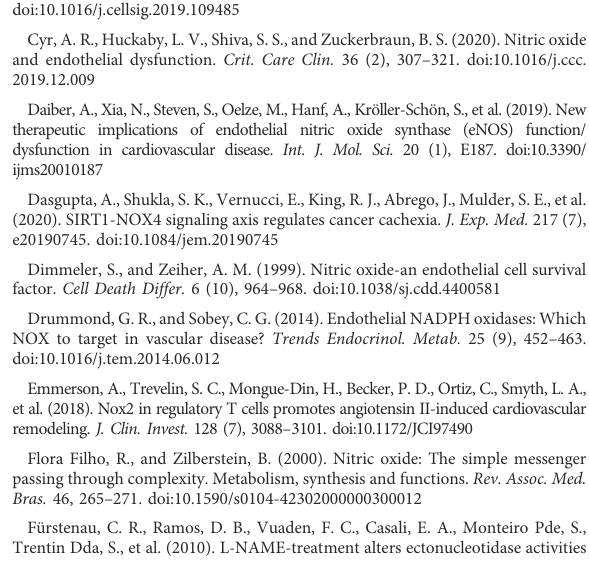
Cell viability of the thymus-derived endothelial cell line tEnd.1 after treatment with L-arginine (100 µM) and L-NAME (1, 10, 100 µM, 1 mM) for 12, 24, 48, 72, 96 and 120 h without retreatment. Data (mean ± standard deviation, n =5) wereanalyzed by Twoway ANOVA, followed by Tukey ’ s multiple comparisons test. (*represents signi fi cant difference between groups, for p < 0.0001). SUPPLEMENTARY FIGURE S2 Cell viability of the thymus-derived endothelial cell line tEnd.1 after treatment with L-arginine (100 µM) and L-NAME (1, 10, 100 µM, 1 mM) for 12, 24, 48, 72, 96 and 120 h with retreatment every 24 h. Data (mean ± standard deviation, n = 5) were analyzed by Two-way ANOVA, followed by Tukey ’ s multiple comparisons test. (*represents signi fi cant difference between groups, for p < 0.0001). SUPPLEMENTARY FIGURE S3 Nitrite concentration in culture medium of the thymus-derived endothelial cell line tEnd.1after treatment with L-arginine (100 µM) and L-NAME (1, 10, 100 µM, 1 mM) for 12, 24, 48, 72, 96, and 120 h without retreatment. Data (mean ± standard deviation, n =5) were compared by Two-way ANOVA, followed by Tukey ’ s test. (*represents statistically signi fi cant difference compared between groups for p < 0.0001). SUPPLEMENTARY FIGURE S4 Nitrite concentration in culture medium of the thymus-derived endothelial cell line tEnd.1 after treatment with L-arginine (100 µM) and L-NAME (1, 10, 100 µM, 1 mM) for 12, 24, 48, 72, 96 and 120 h with retreatment every 24 h. Data (mean ± standard deviation, n = 5) were compared by Two-way ANOVA, followed by Tukey ’ s test (*represents statistically signi fi cant difference compared between groups for p <